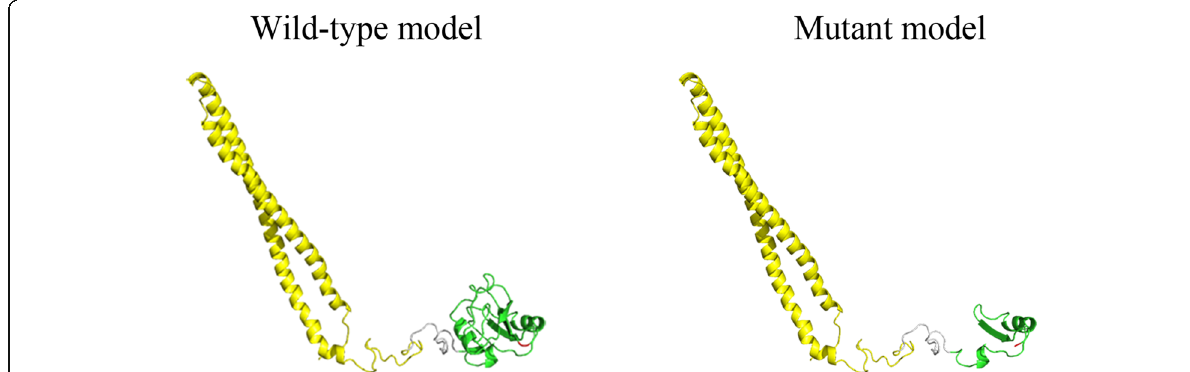
Fig. 3 Homology models of the wild-type PIK3R1 and p.Gln654* mutant PIK3R1 . The inter src-homology 2(iSH2) domain and C-terminal src- homology (cSH2) domain are shown in yellow and green respectively, with the PIK3R1 G654 shown in